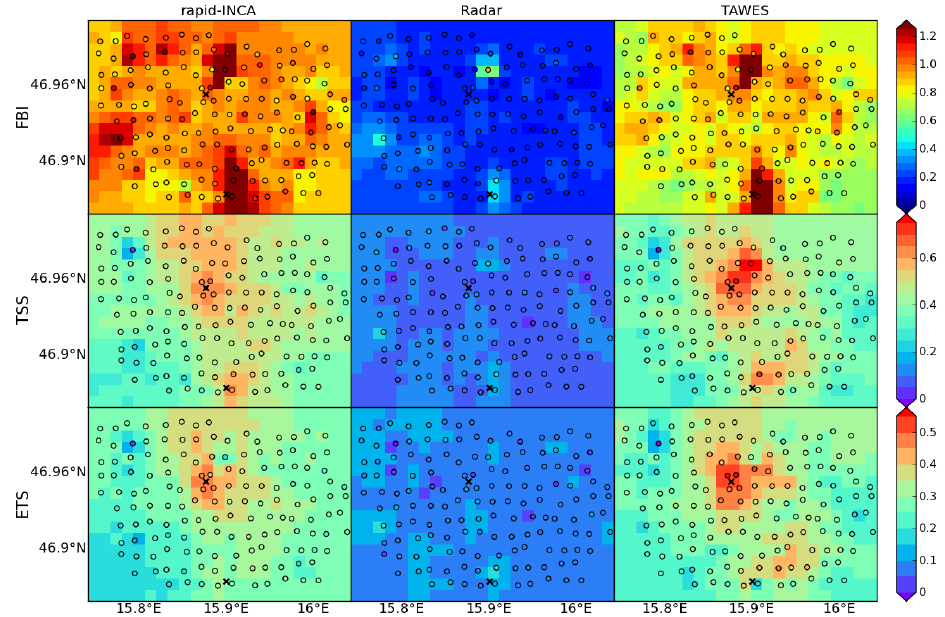
Figure 13. Skill scores for rapid-INCA, radar and TAWES stations at each WegenerNet station. Circles represent the exact values; the image is obtained by interpolation to the INCA grid.